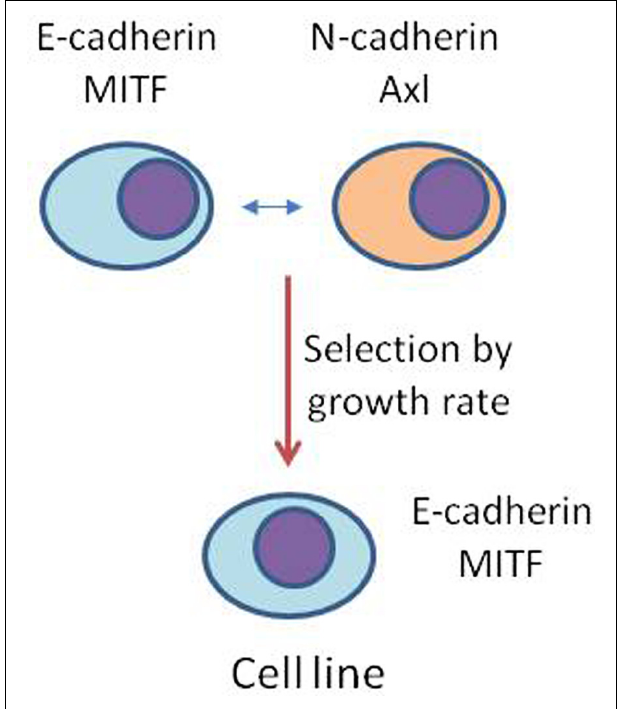
FIGURE 6 | Possible model for the generation of melanoma cell lines. Phenotypic switching in vivo generates a highly heterogeneous population of cells that vary in expression of proteins such as E-cadherin, N-cadherin, Axl, and M-MITF. Derivation of a cell line, by selecting for rapid proliferation, may select for an individual